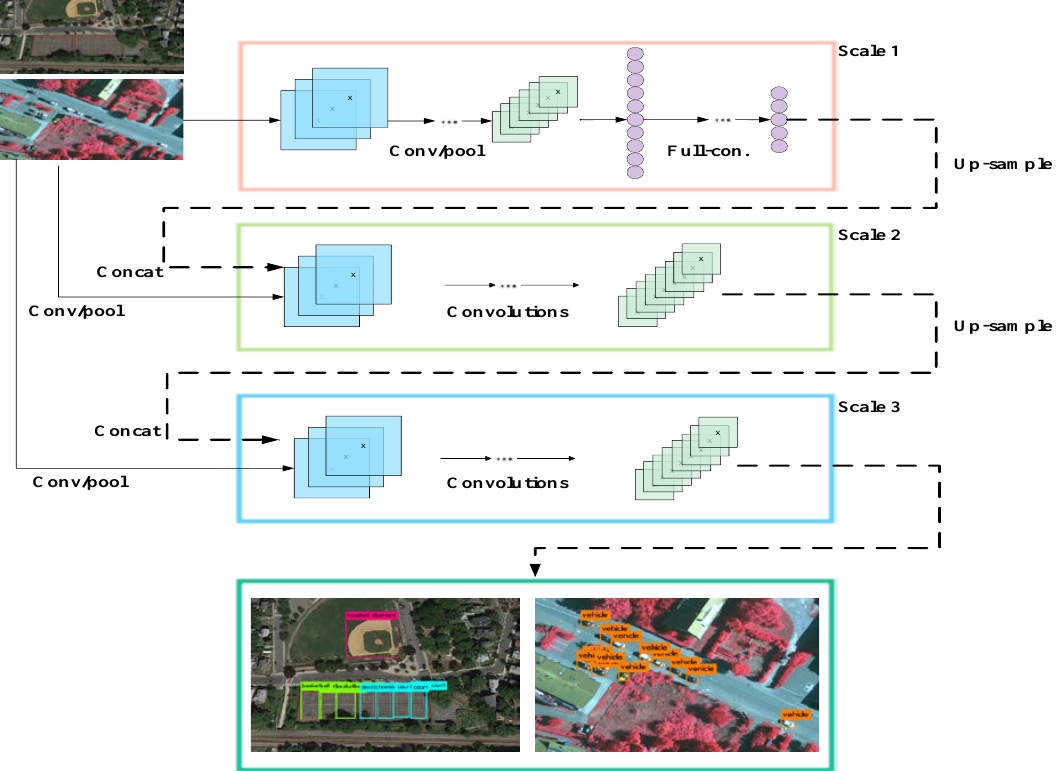
Figure 4. The workflow of connecting multiple layers.